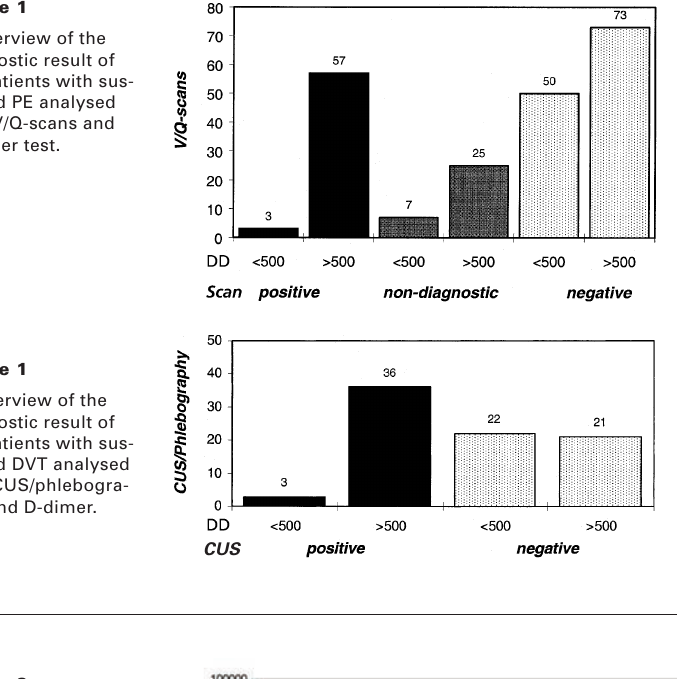
D-dimer concentra- tions are depicted on a logarithmic scale for the three different V/Q scan result groups. The red hori- zontal line shows the D-dimer cut off of <500 µ g/l and the lower line indicates the cut off at <350 µ g/l. The data demonstrate a speci- ficity of 92% (95% confidence interval = 89–95%) for the cut- off at <500 µ g/l and of 100% at 350 µ g/l